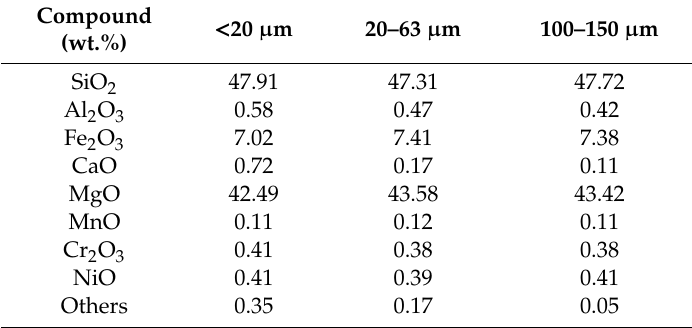
Table 1. Chemical composition of the Norwegian olivine fractions after grinding and sieving. Compound